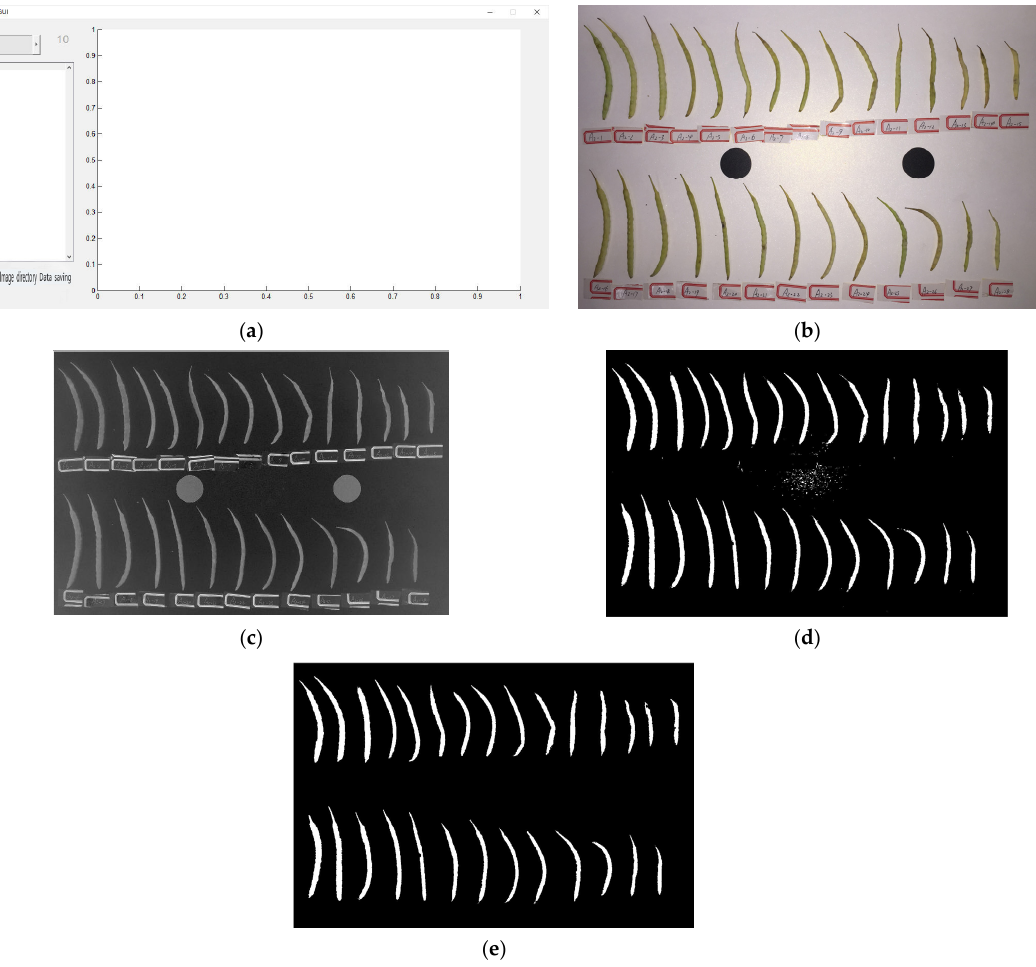
Figure 5. Image processing process: ( a ) Image processing system interface; ( b ) Loading the artwork; ( c ) Image preprocessing; ( d ) Image segmentation; ( e ) Filling and removing impurities.